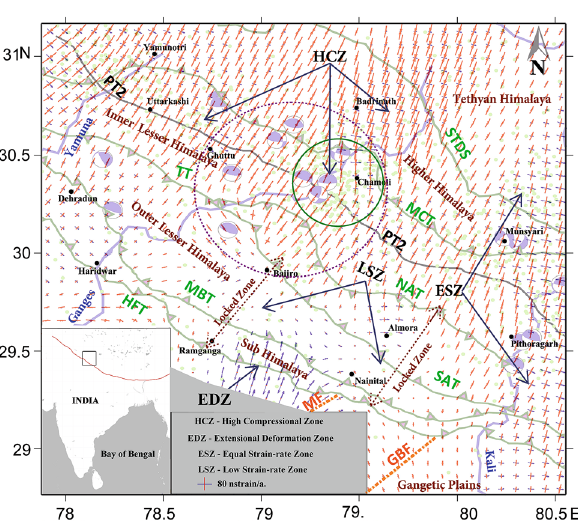
Figure 3. Overall strain rates in the Garhwal–Kumaun region. The red arrows in the strain vectors indicate the compressional axis and the blue arrow shows the extensional component. High compression zone (HCZ), Extensional deformational zone (EDZ), Equal strain-rate zone (ESZ), Low strain-rate zone (LSZ), and the locked zone are marked. The Chamoli earthquake cluster is marked by the green circle. Seismicity of the region is given in green dots and available focal mechanism solutions (Supplementary Table. 1) are also marked as beach balls. The wider violet dotted circle represents the curvilinear deformation field focusing to the Chamoli cluster. The black rectangle given in the inset map at the left bottom corner of the plot indicates the study area. Base map of the plot was created using Generic Mapping Tool (GMT) open source software version 5.4.5 (https:// www. gener ic- mappi ng- tools. org/) and the further modifications are done using the Global Mapper software (https:// www. bluem arble geo. com/ global-